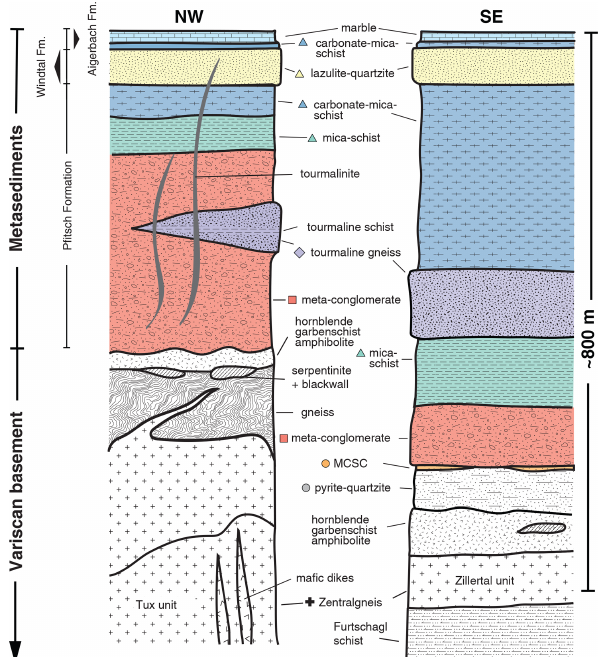
Figure 2. Schematic stratigraphic columns of the rocks from the Pfitsch–Mörchner basin, reconstructed from Lammerer (1986), Veselá and Lammerer (2008), and own mapping. Shown is the sit- uation on the NW and SW limb of the syncline near to the road to the Pfitscher Joch as it might have appeared after sedimenta- tion, neglecting Alpine deformation (e.g., the originally crosscut- ting tourmalinite dike in the NW limb is isoclinally folded and ori- ented parallel to strike). Note that along-strike thickness of the units varies; e.g., the pyrite quartzite in the SE limb is much thicker at Rotbachlspitze, and it pinches out towards the SW and